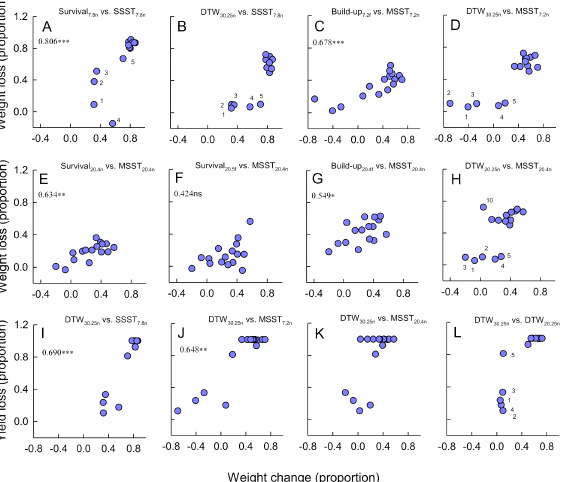
Figure 4. Bi-plots indicating ( A – K ) plant weight change during bulk tests with planthoppers (x-axes) and in corresponding performance tests (y-axes). A bi-plot of total plant weight loss and yield loss during the DTW tests is presented in L . Graphs include the results of ( A ) the Survival 7.8n and ( B ) DTW 30.25n plotted against results from the SSST 7.8n , results from ( C ) the Build- up 7.2f and ( D ) DTW 30.25n against results from the MSST 7.2n , and results from ( E ) the Survival 20.4n , ( F ) Survival 20.5f , ( G ) Build-up 20.4f and ( H ) DTW 30.25n tests against results from the MSST 20.4n test. Estimated losses to yields from the DTW 30.25n tests are plotted against plant weight loss from ( I ) the SSST 7.8n , ( J ) the MSST 7.2n , ( K ) the MSST 20.4n and ( L ) the DTW 30.25n tests. The results of Spearman’s correlations are indicated in ( A , C , E , G , I – L ) where *** p < 0.001, ** p < 0.01, * p < 0.05, and ns = p > 0.05. Note that negative values indicate overcompensation. Symbol labels indicate rankings from the SSST 7.8n as 1 = Rathu Heenati, 2 = IR62, 3 = PTB33, 4 = IR65482-4, 5 = Triveni and 10 = Utri Rajapan. Weight loss to seedlings per unit weight of planthopper varied according to pheno- typing test (F 2,150 = 4.722, p = 0.010) (Figure 5). Varieties IR40, IR65482-7, Utri Rajapan, and TKM6 tended to have relatively high damage per unit weight gain of planthoppers compared to the remaining varieties, but only in the Survival 7.8n tests (interaction term: F 18,150 = 1.866, p = 0.021), Across tests, weight losses per unit planthopper were similar (F 9,150 = 1.724, p = 0.088). A correlation ( r s 11 = 0.737, p < 0.010) between per unit damage and SSST 7.8n results indicates that the damage rating for the test is highly affected by a lack of plant tolerance at early seedling stages (Figure 5A). Weight loss per unit weight of planthopper generally declined in the Build-up 7.2 tests (Figure 5B,C) ḟ ” indicating a greater tolerance to planthopper damage in older